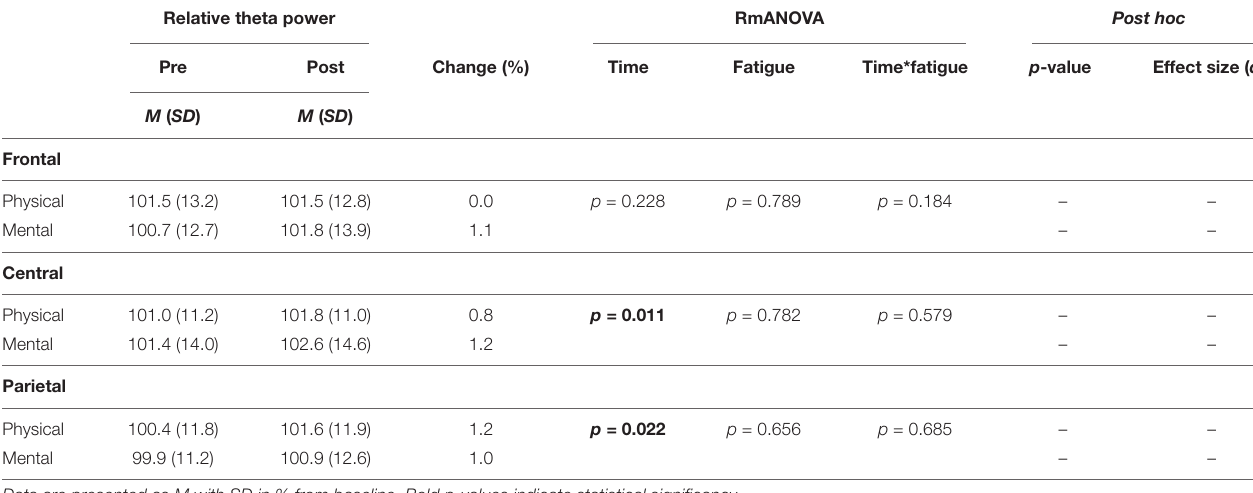
TABLE 3 | Averaged theta frequency power relative to baseline values pre and post to PF and MF within the respective ROIs as well as rmANOVA results and post hoc tests. Relative theta power